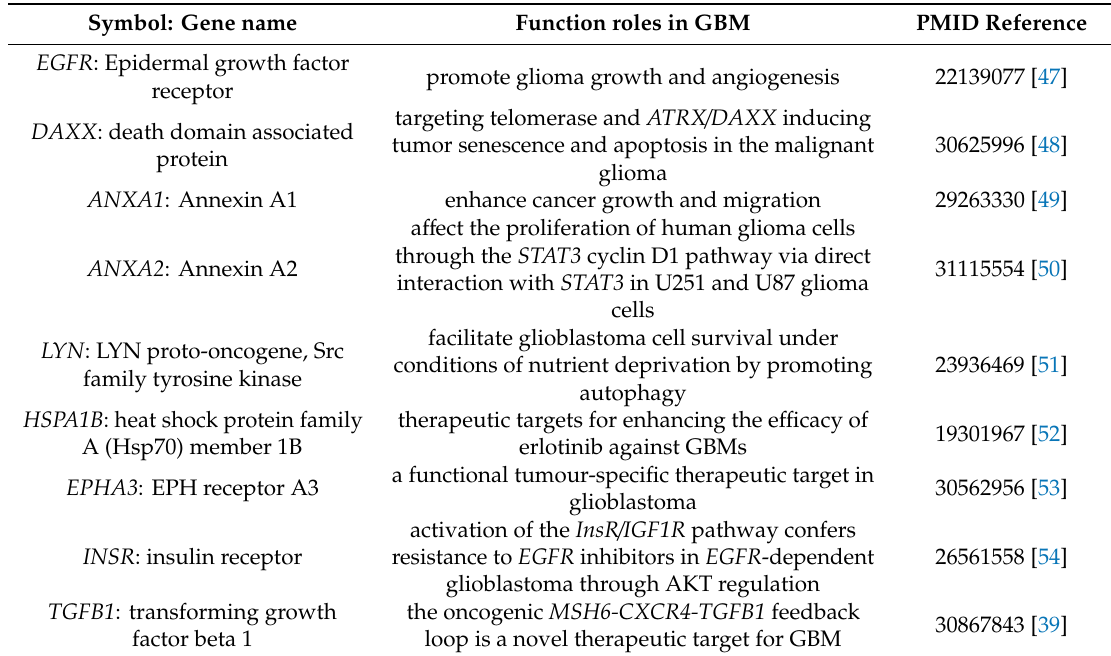
Table 3. The biological functions, corresponding PubMed IDs and literature references for enriched genes by GO enrichment analyses between GBM and